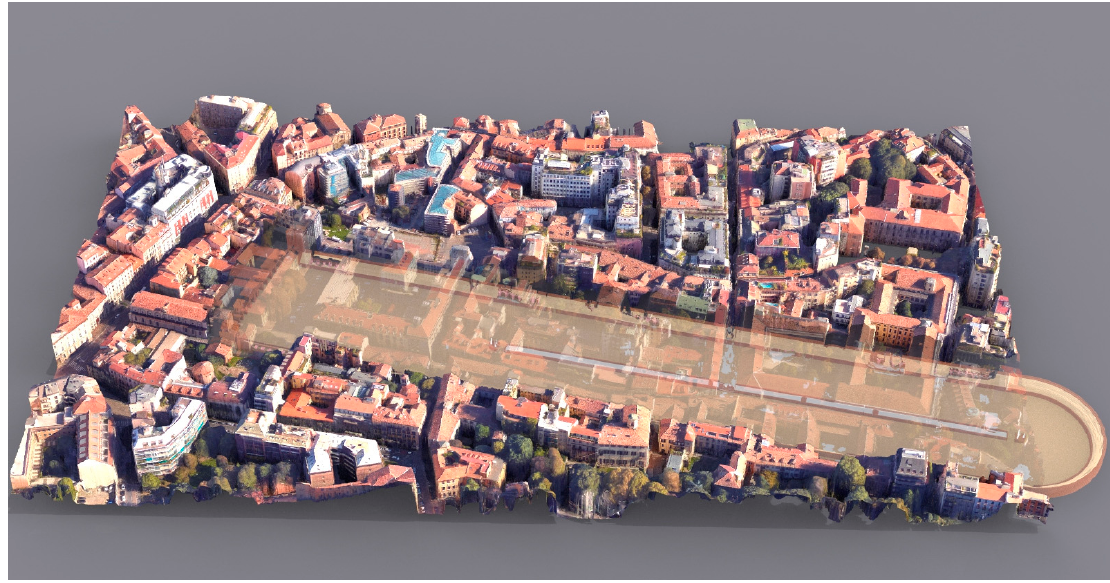
Figure 14. The overlapping of the georeferenced reconstruction of the circus on 3D map of the related area.